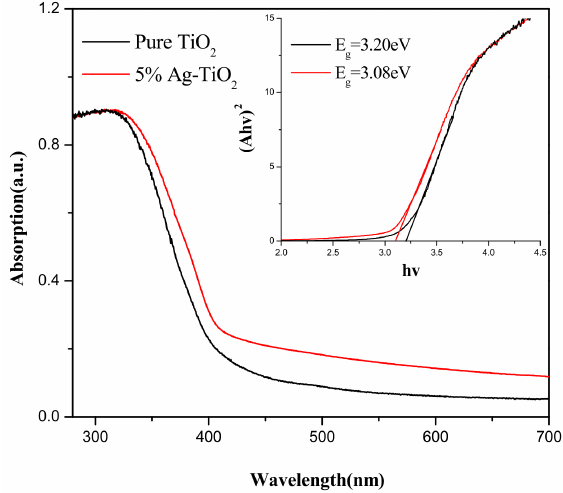
Figure 5. UV-Vis absorption spectra of TiO 2 and 5% Ag-TiO 2 . With hv as the horizontal coordinate and (A hv ) 2 as the vertical coordinate for the graph, the Eg of each sample can be obtained after making a tangent line to the horizontal coordinate, and the Eg of each sample is 3.2 eV and 3.08 eV, respectively, which shows that Ag loading on the TiO 2 surface can effectively reduce the forbidden bandwidth of the samples and extend their photo-response range. Furube et al. [51] pointed out that Ag loading on the TiO 2 surface created a surface plasmon resonance (SPR) effect that extends light absorption into the visible region while increasing the photocatalysis efficiency of TiO 2 under visible